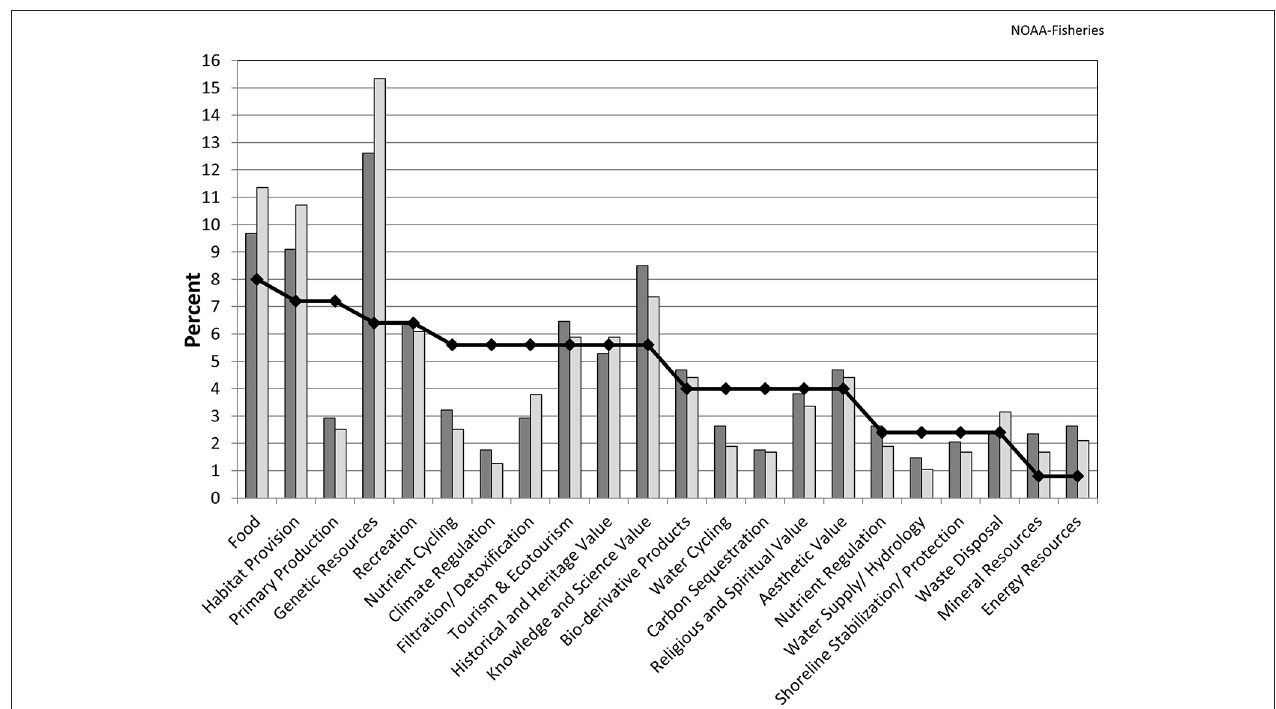
FIGURE 3 | The normalized value of all the mandates collectively is shown for the subset of mandates informing the mission and activities of NOAA-Fisheries. The dark bars reflect of the number of mandates relevant to each of the identified EGS (count). The light colored bars reflect the collective degree to which the mandates address each EGS. The line shows the normalized organizational priority of the EGS for NOAA-Fisheries expressed as a percent.